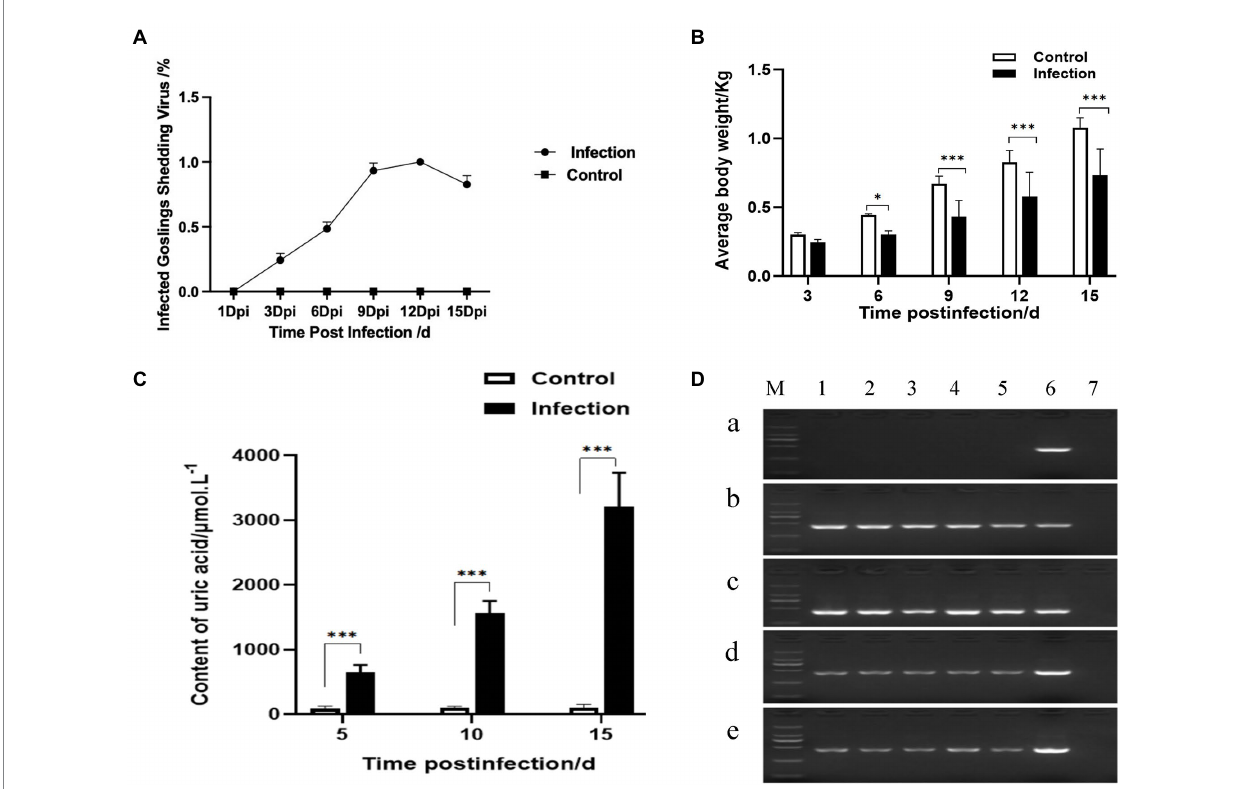
FIGURE 7 Viral shedding, growth performance, uric acid content, and viral RNA detection after GoAstV infection. (A) Viral shedding, (B) body weight monitoring, (C) uric acid level determination, and (D) GoAstV in different organs of goslings after challenge. M: 2000 DNA Marker; 1: heart; 2: liver; 3: spleen; 4: